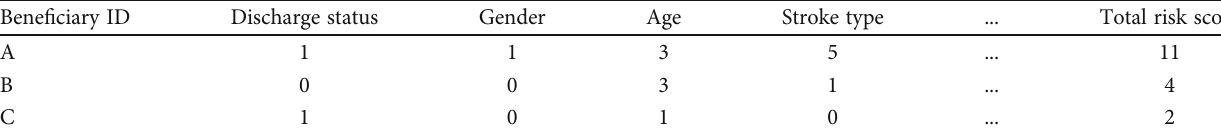
Table 2: Total risk score calculation.